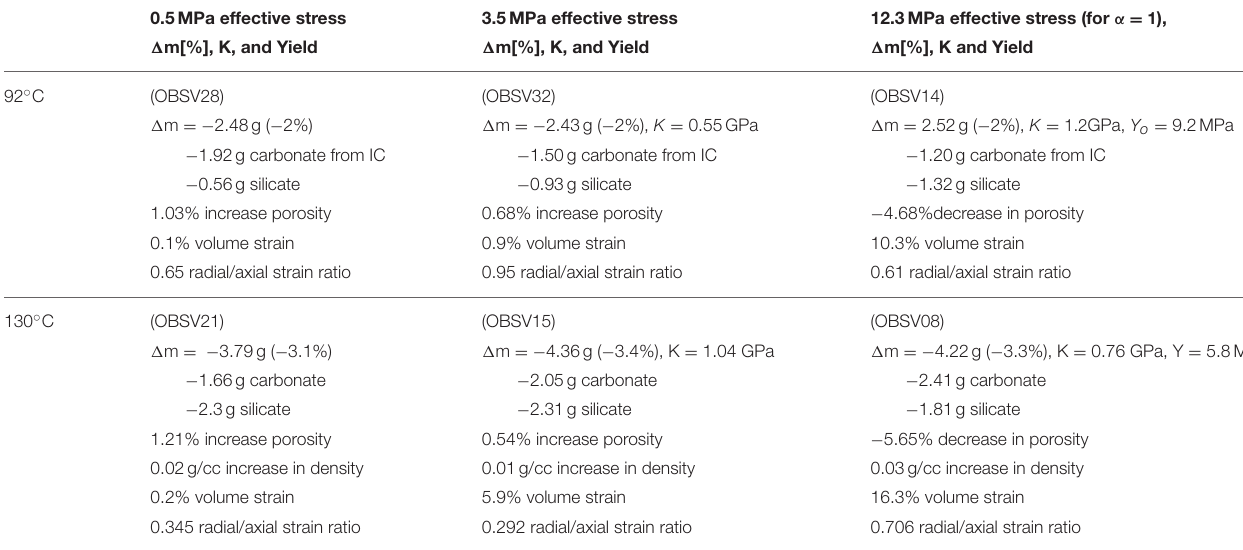
TABLE 7 | Summary of the results of all experiments performed at the two temperatures and the three